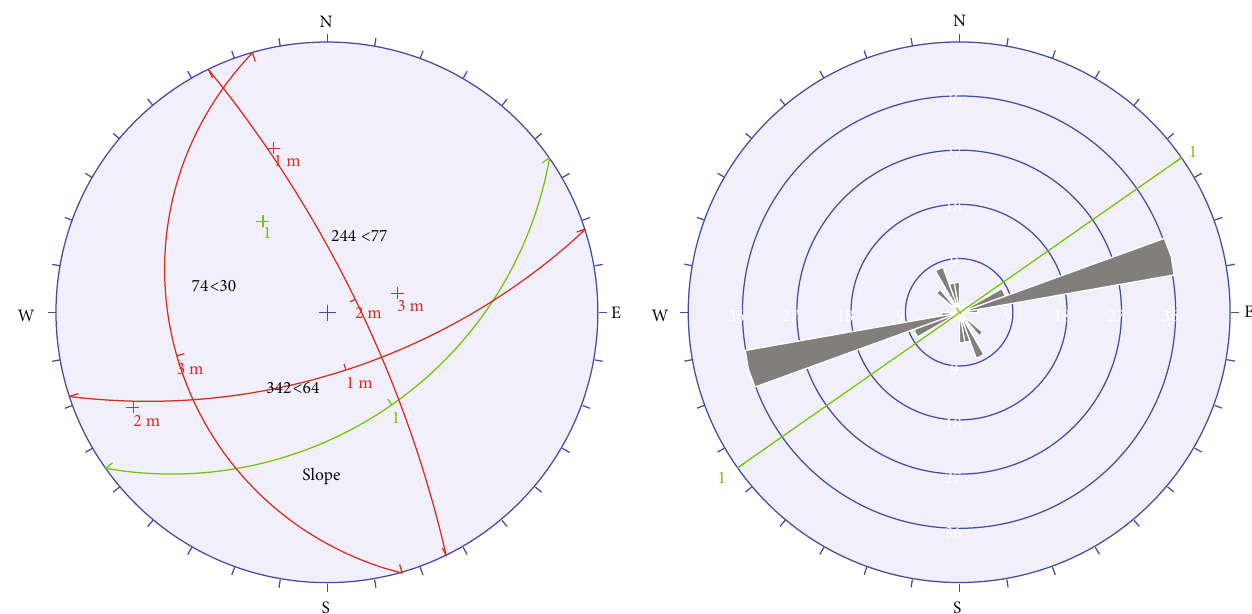
Figure 4: No. 3 observation point stereographic projection and joint rose map.